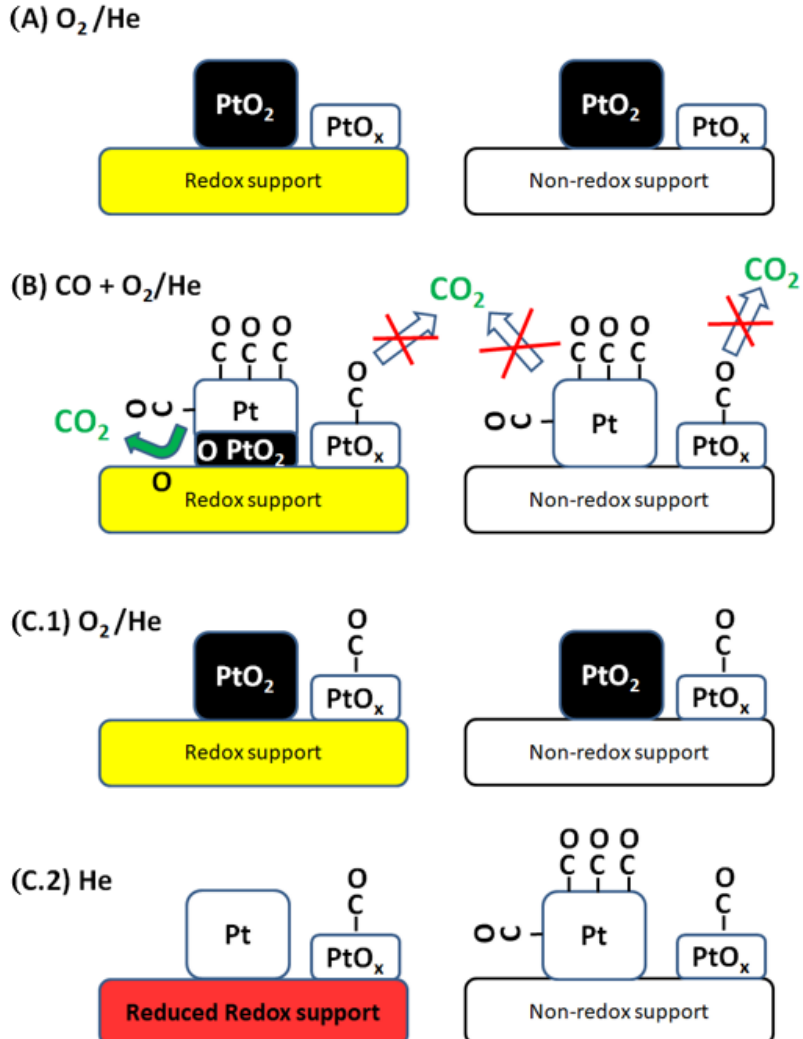
Figure 8. Schematic representation of the steady-state of various Pt nanostructures depending on the support and gases they are exposed to at room temperature. One of the Pt nanostructures, such as a large nanoparticle, is able to be fully oxidized or reduced depending on feed composition, while the other nanostructure, such as a cluster PtOx or an isolated Pt cation, remains oxidized. ( A ) All Pt phases are oxidized under O 2 , ( B ) Only redox-based supports lead to a significant CO oxidation activity at room temperature. CO adsorbed on reduced Pt site reacts with oxygen from the redox support or from an adjacent oxidized Pt phase. ( C.1 ) If only CO is removed from the feed, large Pt nanoparticle are reoxidised whatever the support, while CO remains strongly adsorbed on inert PtOx domains. ( C.2 ) If both CO and O 2 are removed from the feed, the adsorbed CO left over large nanoparticles will react and leave the large Pt nanoparticles and redox support partly reduced. In the case of a non-redox support, all Pt linear sites remain covered with CO.